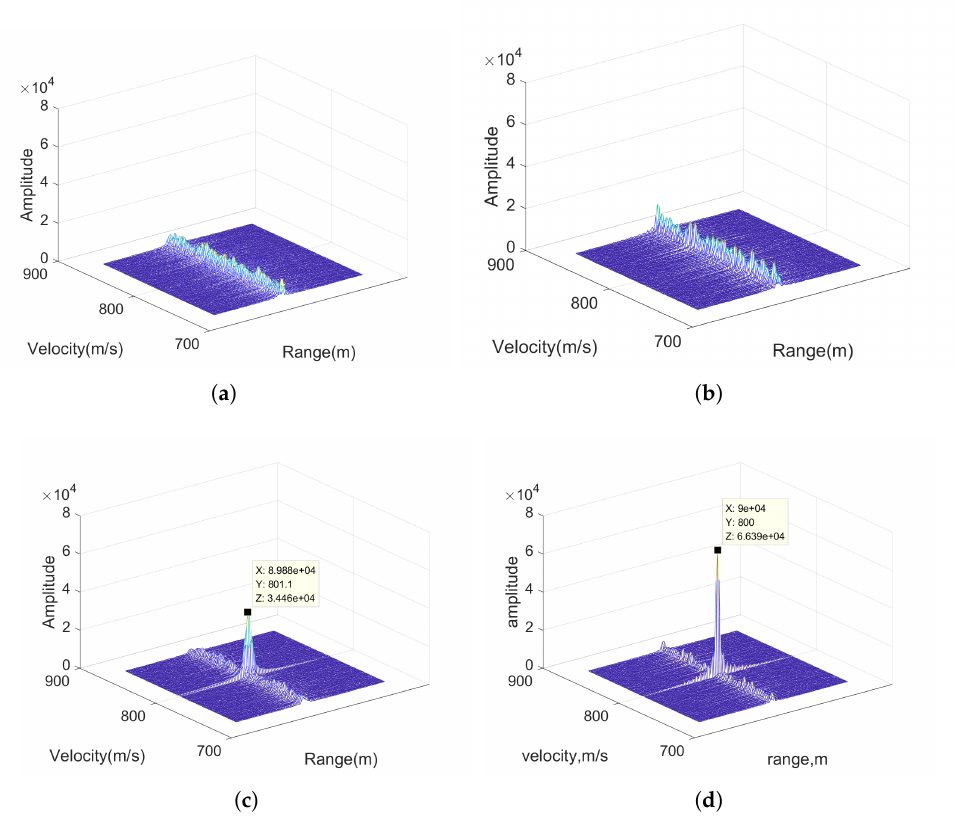
Figure 10. Coherent integration via four method: ( a ) MTD, ( b ) RFT, ( c ) NUFFT among slow time, ( d )